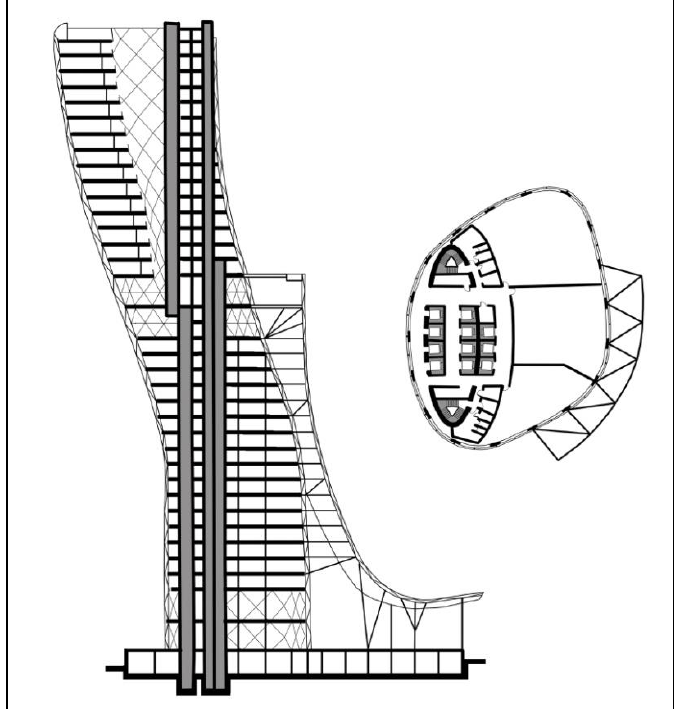
Figure 19. Capital Gate Tower: Floor plan and section (developed by authors on the basis of [45]).